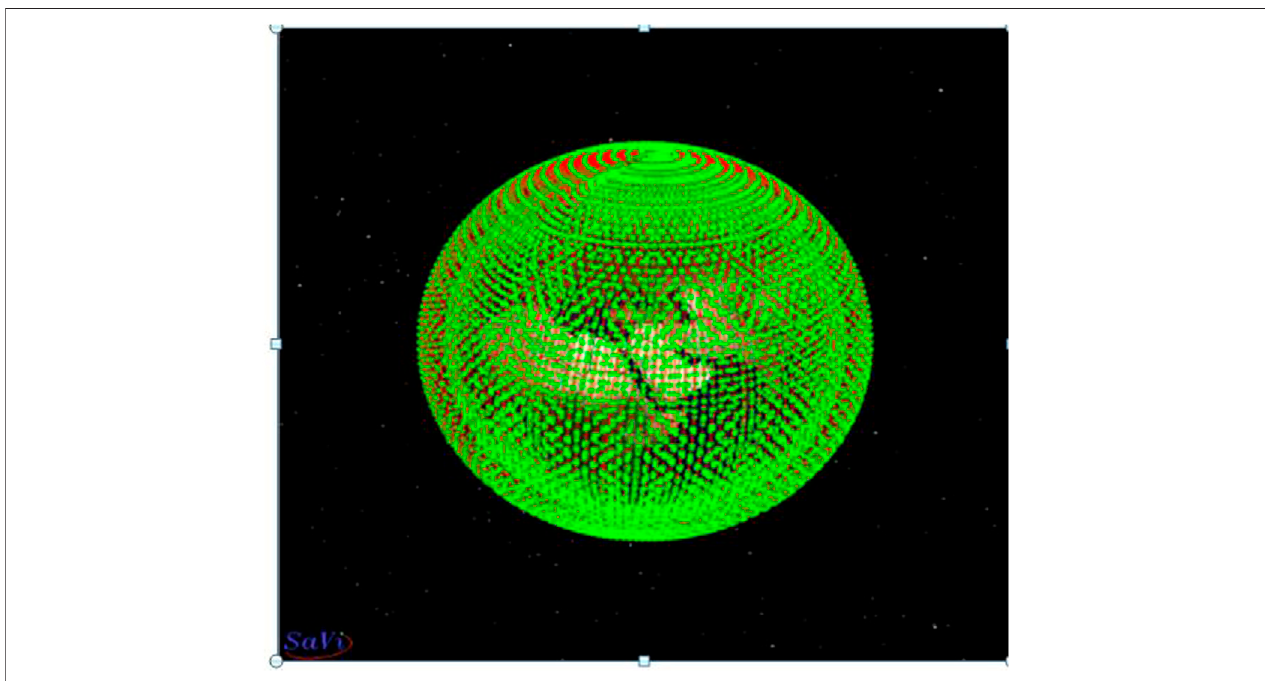
FIGURE 2 | Starlink constellation (11,943 satellites, imaginary representation, created with SaVi [55]) (Yang, 2018; Lutz et al., 2012).